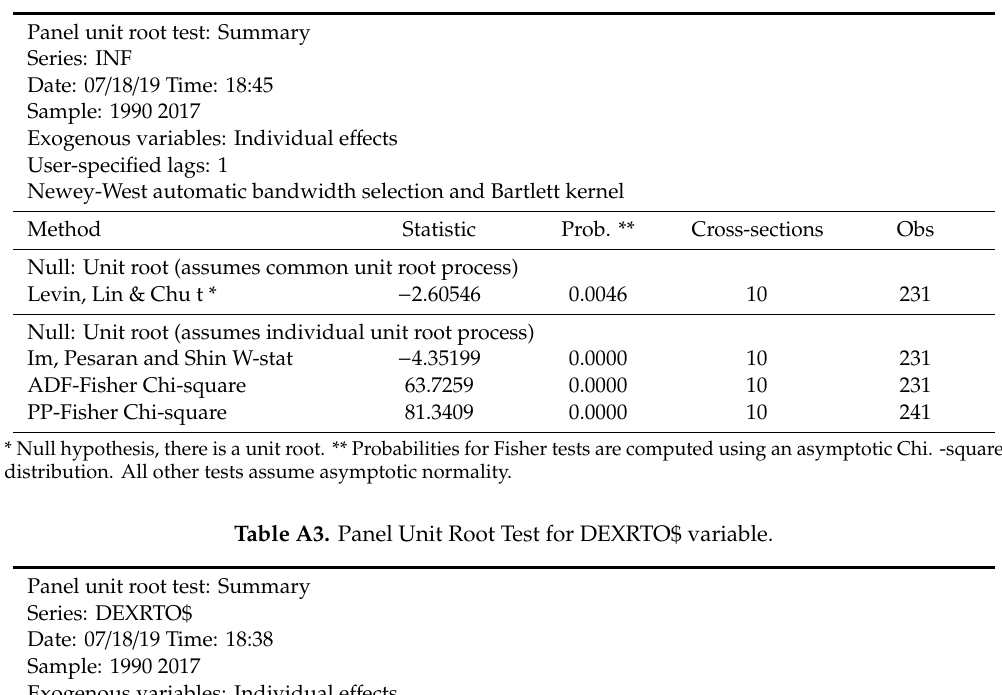
Table A2. Panel Unit Root Test for INF variable.